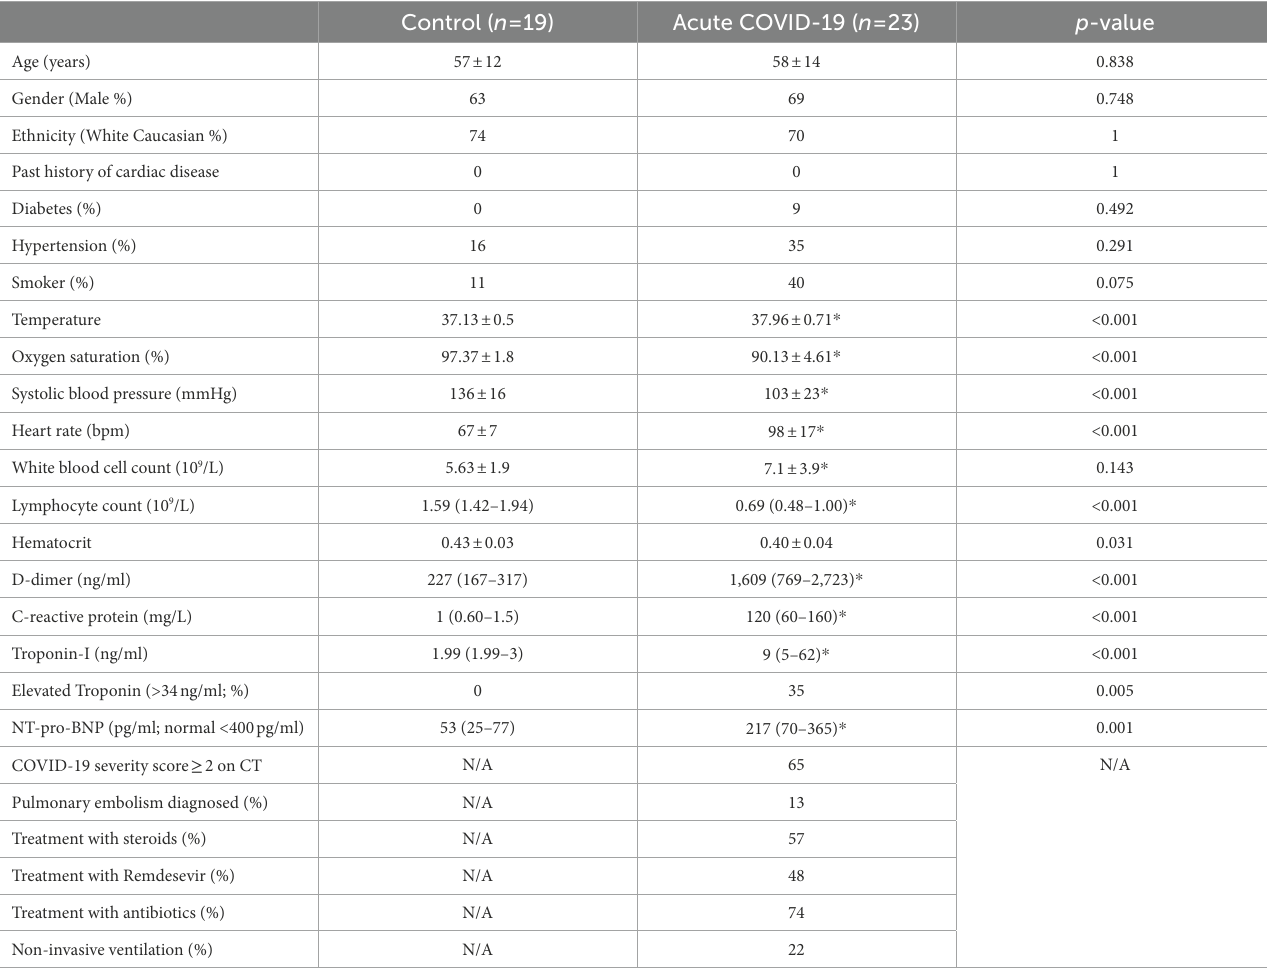
TABLE 1 Baseline characteristics and blood test